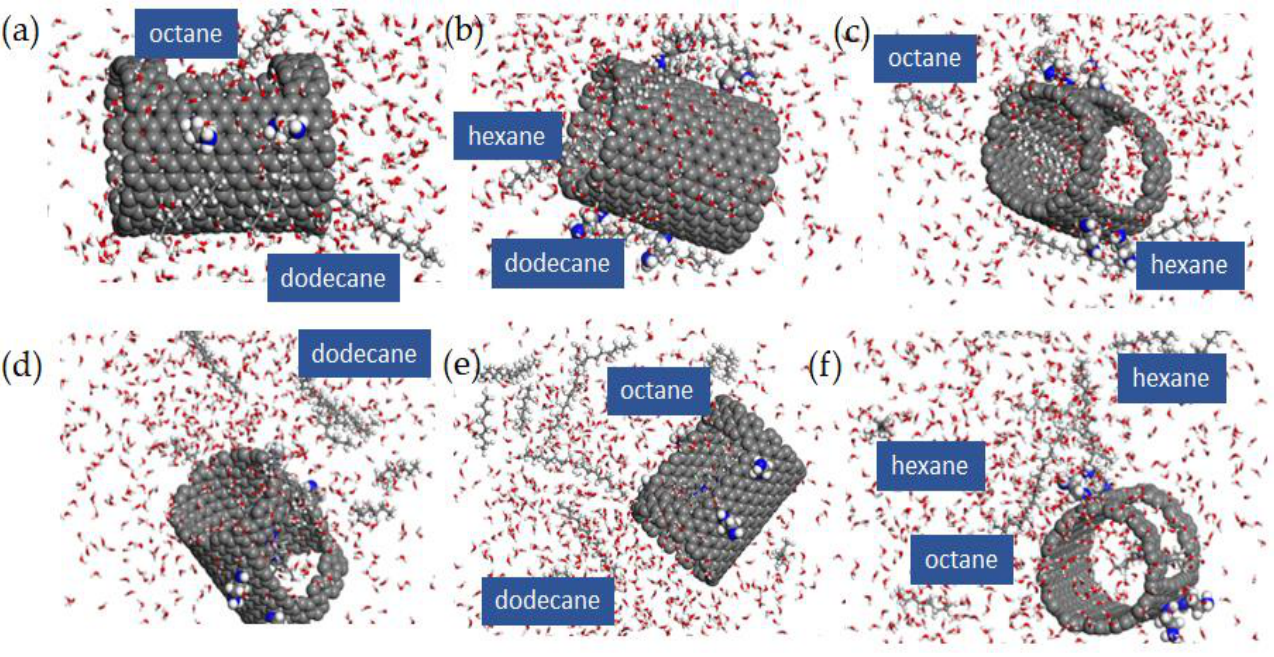
Figure 3. Screenshots of the dynamic simulations of hydrocarbon molecules on NH 2 -CNT at ( a ) 20 ps, ( b ) 100 ps, ( c ) 200 ps. Similar screenshots on the HA-MWCNT at 20, 100, and 200 ps are shown in ( d ), ( e ), and ( f ), respectively.